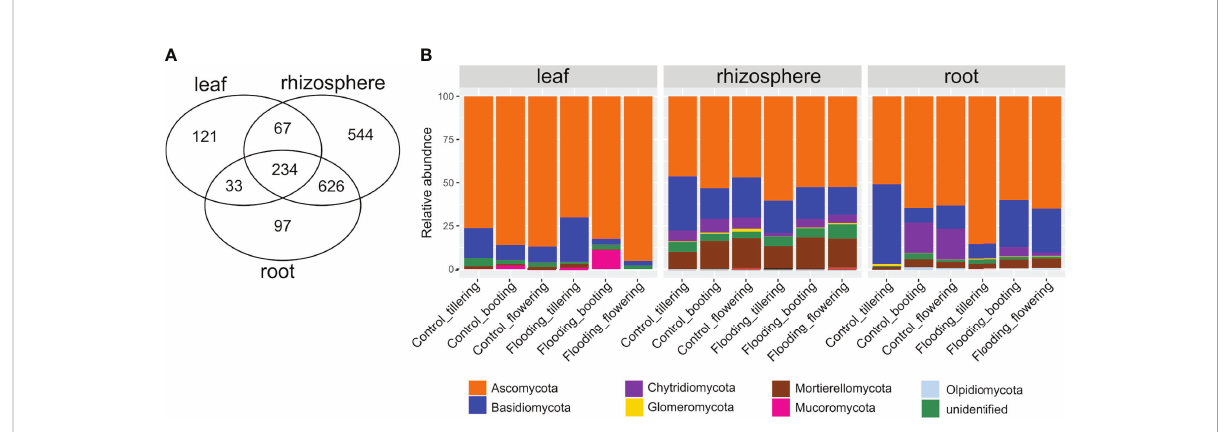
FIGURE 2 Composition of the wheat mycobiota. (A) Venn diagram showing the shared and unique fungal ASVs between soil-plant compartments. (B) Relative abundance of the main fungal phyla composing the wheat mycobiota across plant compartment, plant growth stage and watering